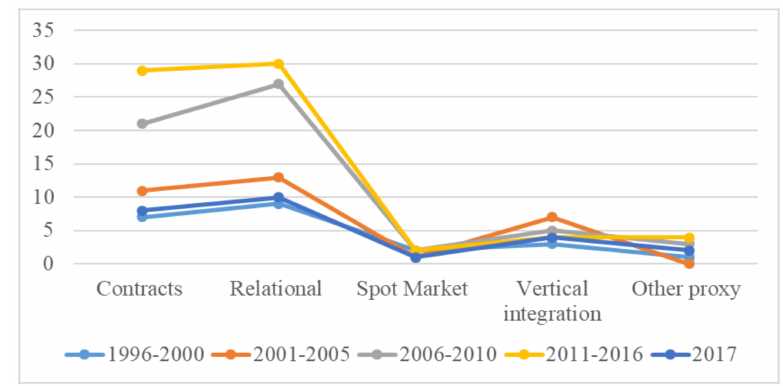
Figure 2. The synthesized governance structures.